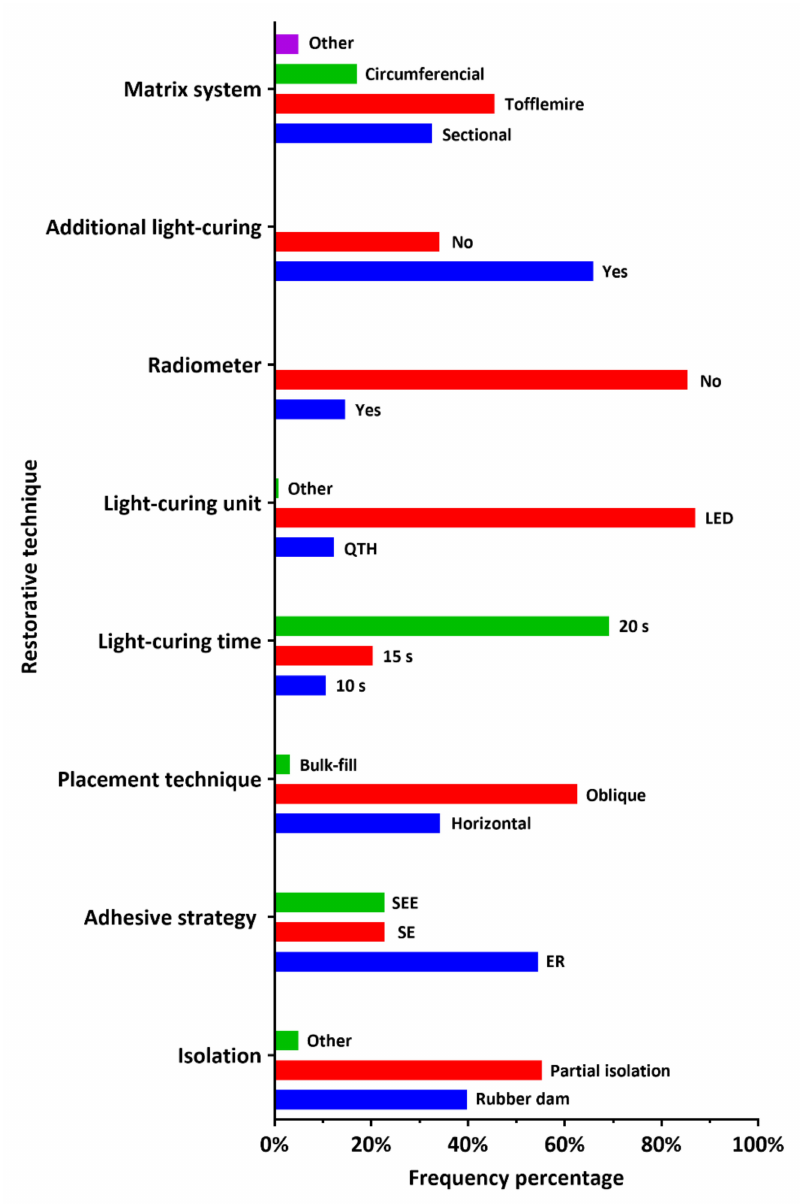
Figure 4. Dental practitioner-reported frequency of the restorative technique applied during the placement of posterior composite restorations (ER: etch-and-rinse, SE: self-etching, SEE: selective enamel etching, QTH: quartz tungsten halogen, LED: light emitting